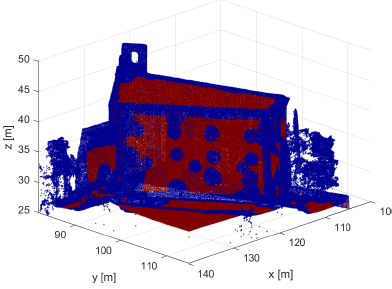
Figure 3. Segmented planar surfaces in the central part of the fortress.